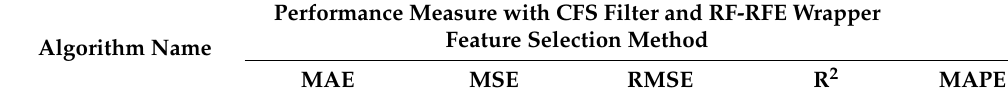
Table 5. Performance metric evaluation of machine learning models with the proposed hybrid feature selection